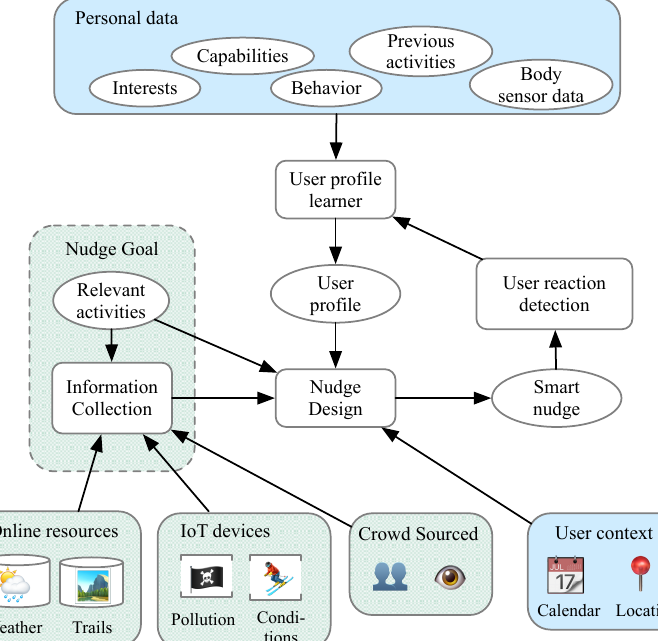
Figure 1. Smart nudging system